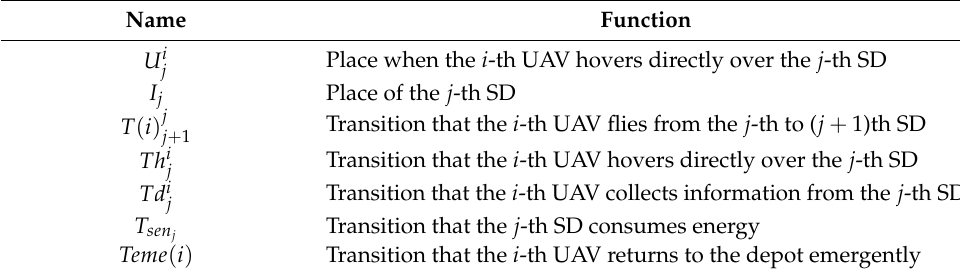
Figure 3. HCCPNS model of multi-UAV aided wireless power and information transfer. Table 2. Description of representative places and transitions.